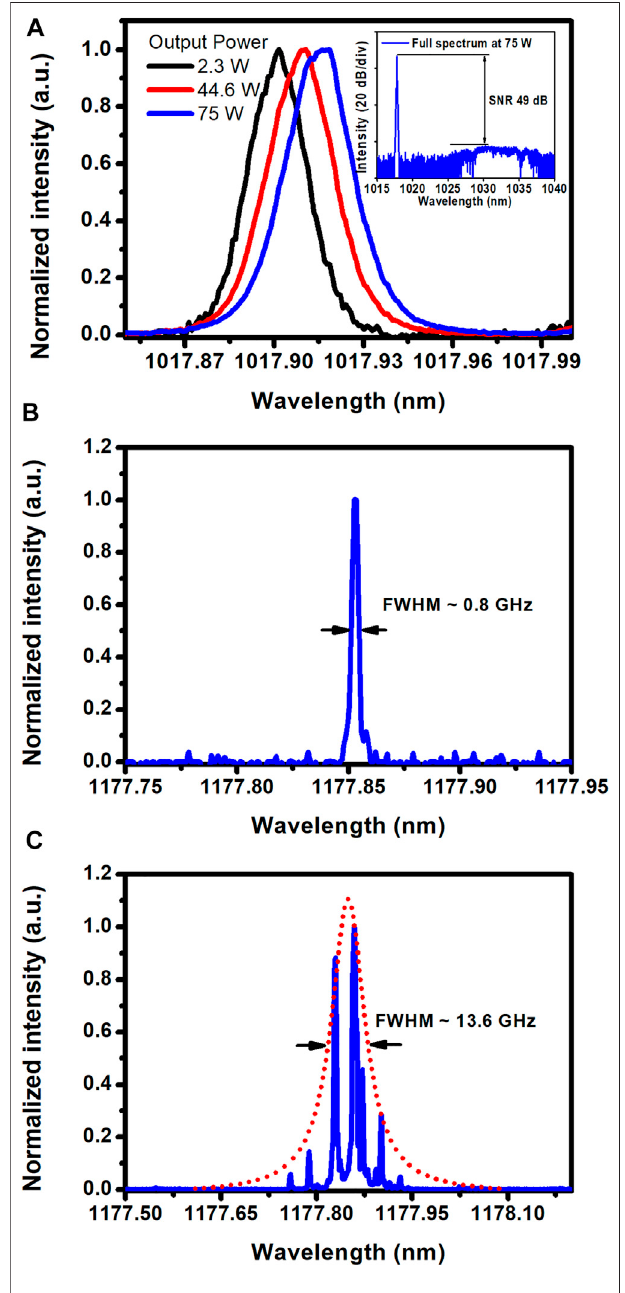
FIGURE 3 | (A) Output spectra of the 1,018 nm fi ber laser at the output power of 2.3, 44.5, and 75 W; inset: a broad output spectrum at the output power of 75 W. (B) An SLM Stokes spectrum at the output powers of 0.6 W. (C) The Stokes spectrum at the output powers of 6.1 W; The Lorentzian curve of the Stokes spectrum (dotted